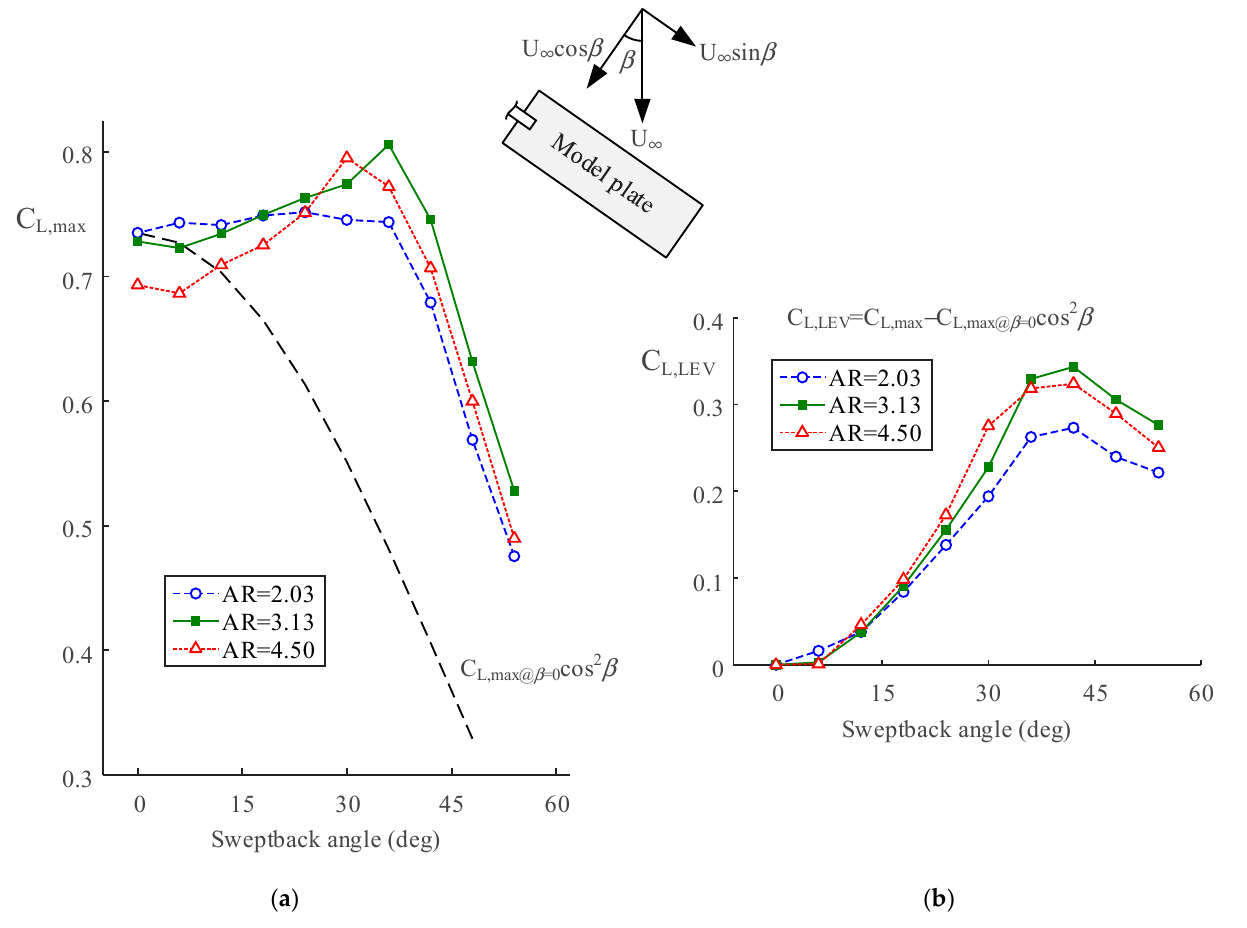
Figure 6. The maximum C L and the contribution of the leading-edge vortex. ( a ) The maximum lift coefficients C L,max with respect to β ; ( b ) The contribution of the leading-edge vortex C L,LEV with respect to β .